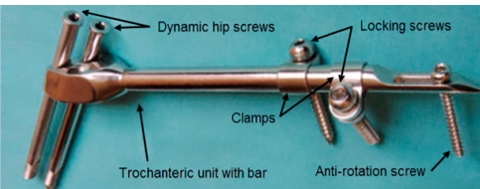
Figure 1. Components of a selfdynamisable internal fixator (SIF) configured for subtrochanteric femoral fracture